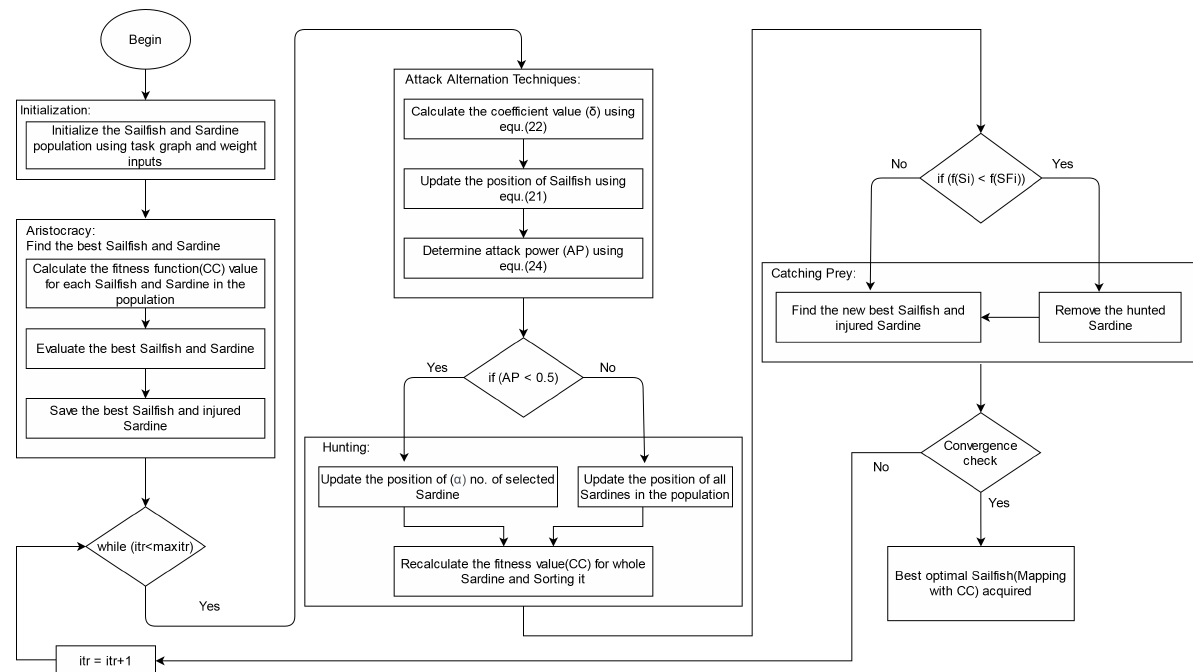
Figure 6. Flowchart for proposed